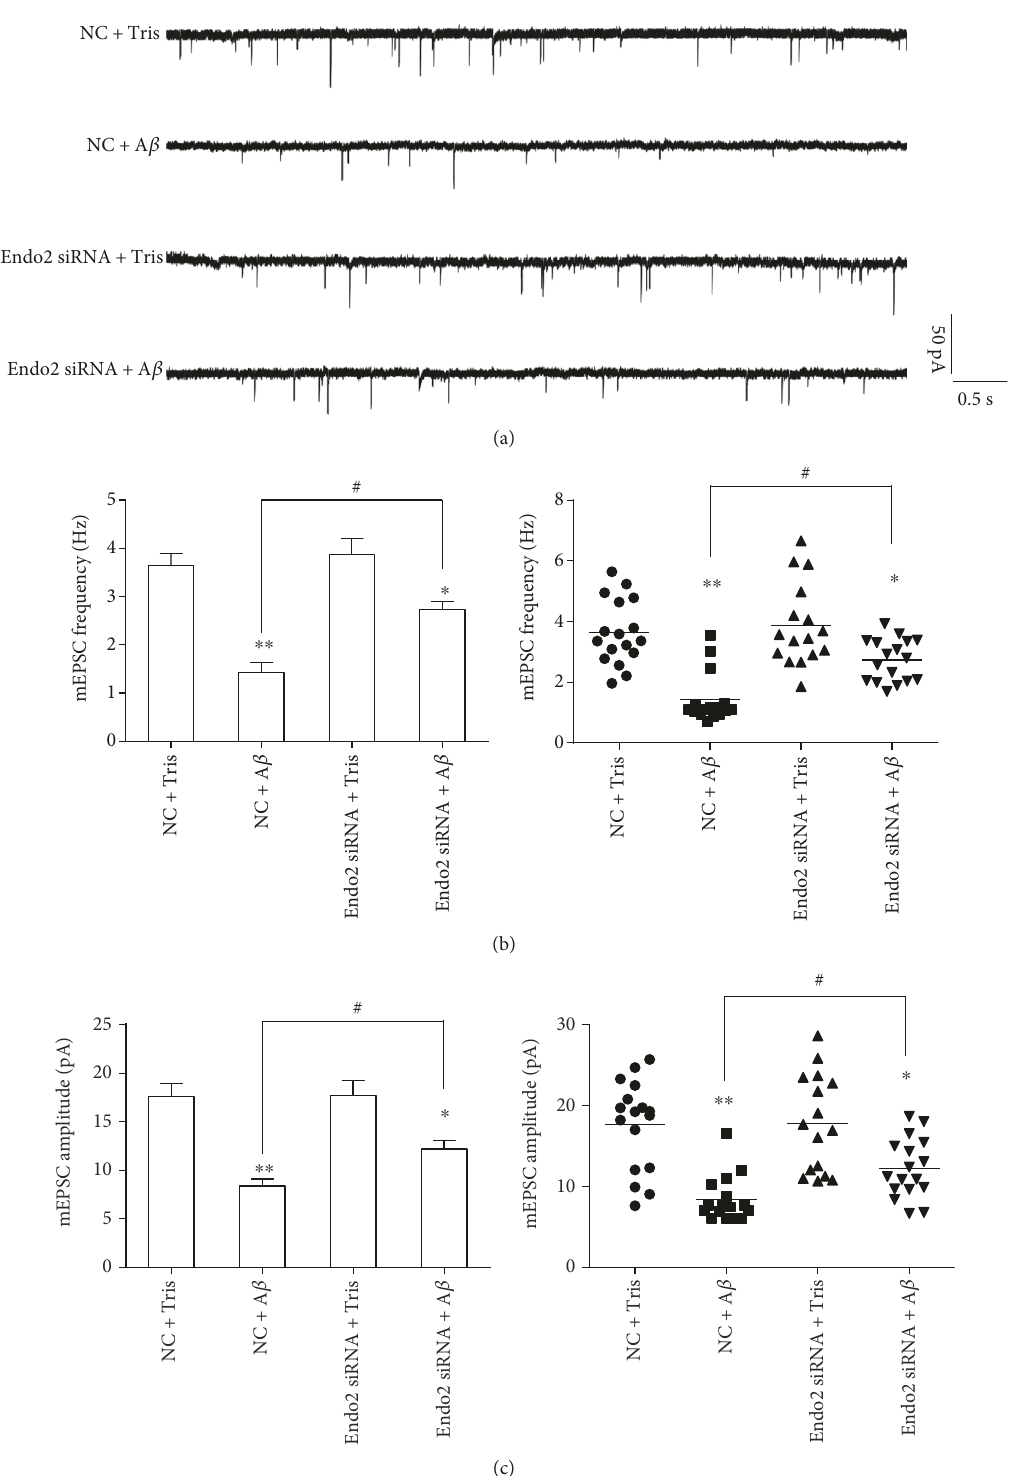
Figure 2: The electrophysiology of endophilin2 knockdown neurons processed by oligomeric A β . (a) mEPSC tracings are shown in control and oligomeric A β -treated neurons transfected with NC and Endo2 siRNA. (b) Histogram plots and scatterplots of mEPSC frequency in control and oligomeric A β -processed neurons transfected with NC and Endo2 siRNA, n = 17 cells in NC + Tris and Endo2 SiRNA +A β groups, n = 16 cells in NC +A β and Endo2 SiRNA +Tris groups, 4 cultures from 8 SD rats, ∗ P < 0 05 , ∗∗ P < 0 005 , and # P < 0 005 . (c) Histogram plots and scatterplots of mEPSC amplitude in control and in oligomeric A β -processed neurons transfected with NC and Endo2 siRNA, n = 17 cells in NC + Tris and Endo2 SiRNA +A β groups, n = 16 cells in NC +A β and Endo2 SiRNA +Tris groups, 4 cultures from 8 SD rats, ∗ P < 0 05 , ∗∗ P < 0 005 , and # P < 0 005